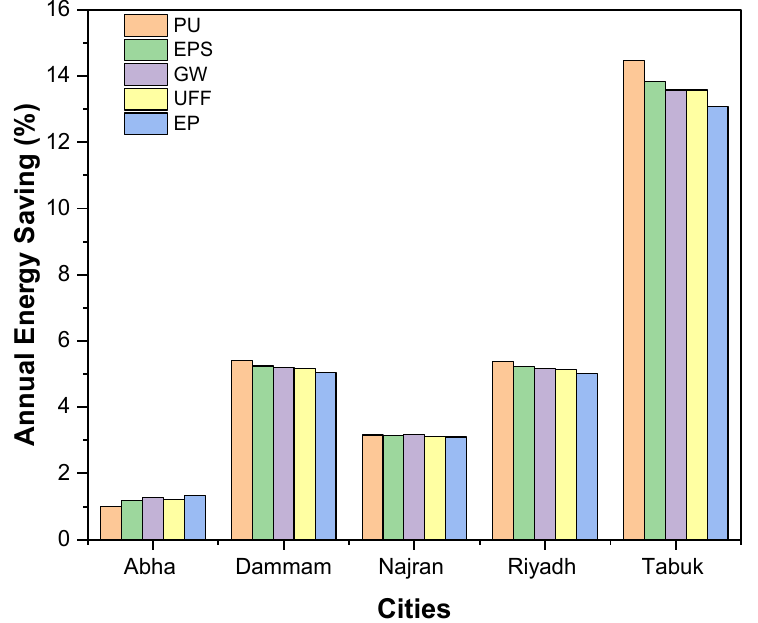
Figure 9. Energy saving potential of various insulation types for different climates.